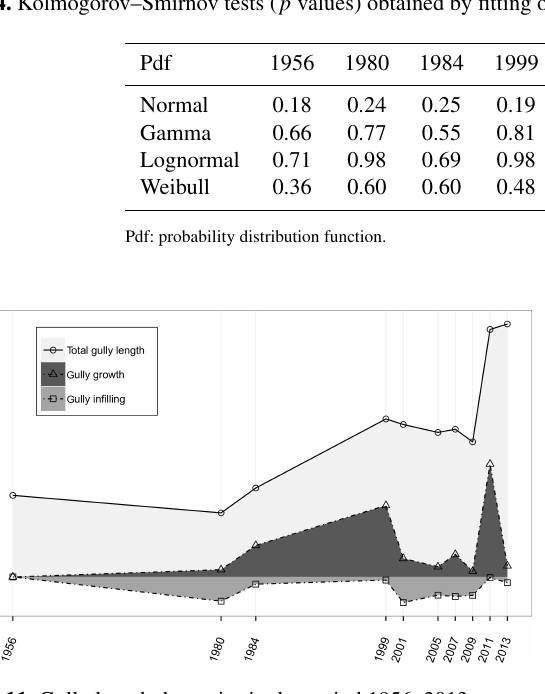
Figure 11. Gully length dynamics in the period 1956–2013.